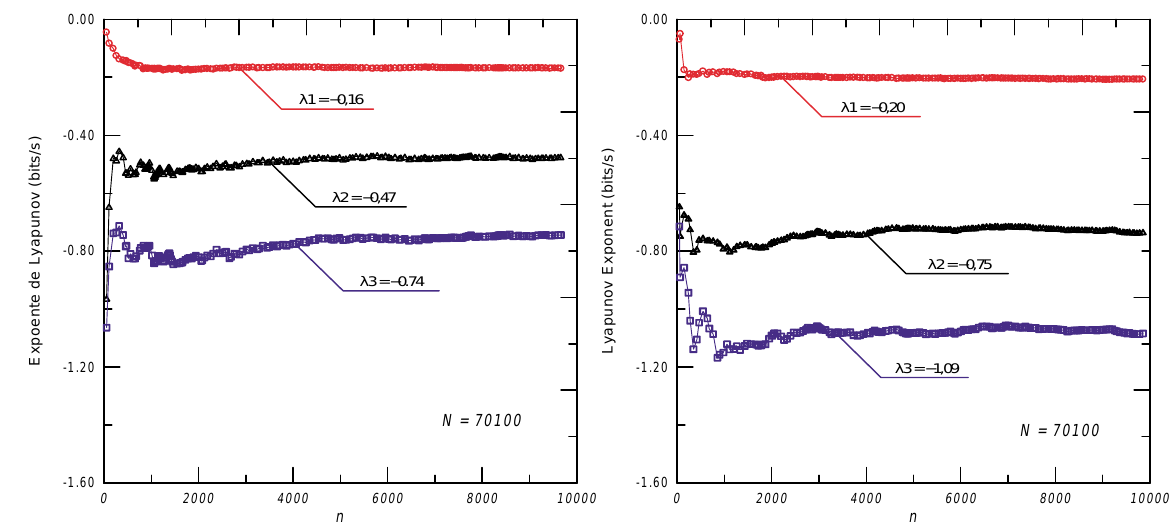
Fig. 13. Spectrum of Lyapunov exponents obtained from the algorithm due to Sano and Sawada: Noisy periodic signal. (a) A = 0.314; (b) 0.628.